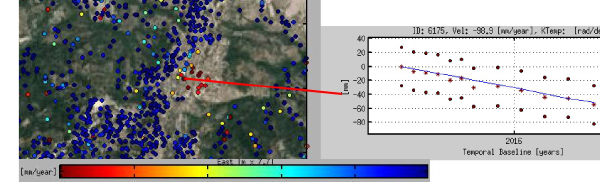
Figure 1. A high rate of landslide movement detected by Sentinel-1A PS InSAR over Babadag village, Turkey.